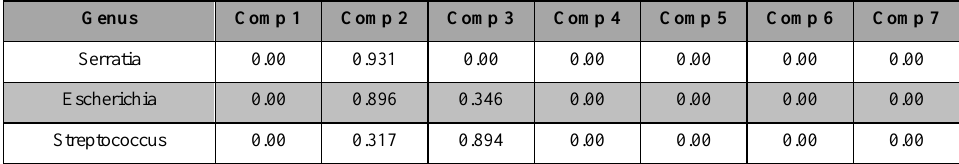
Table 2b. A rotated Component matrix for Genus among Control